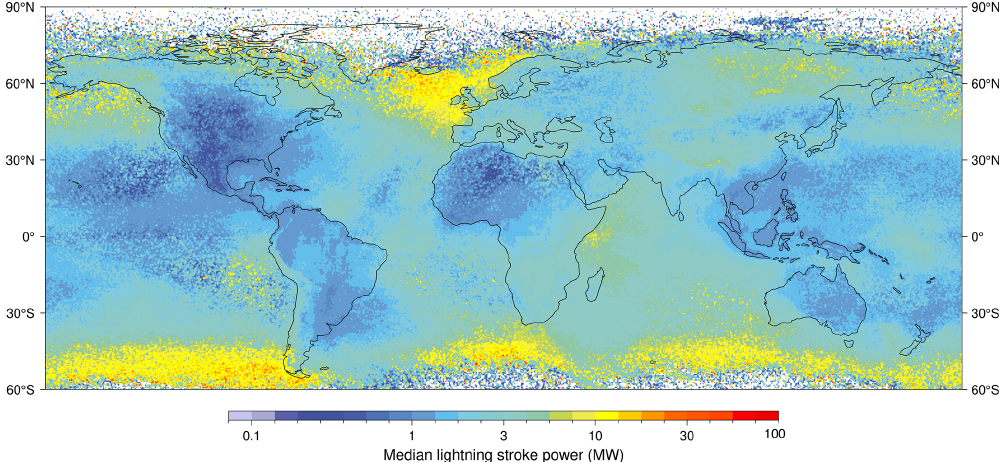
Figure 9. Climatological annual mean of the median lightning power per